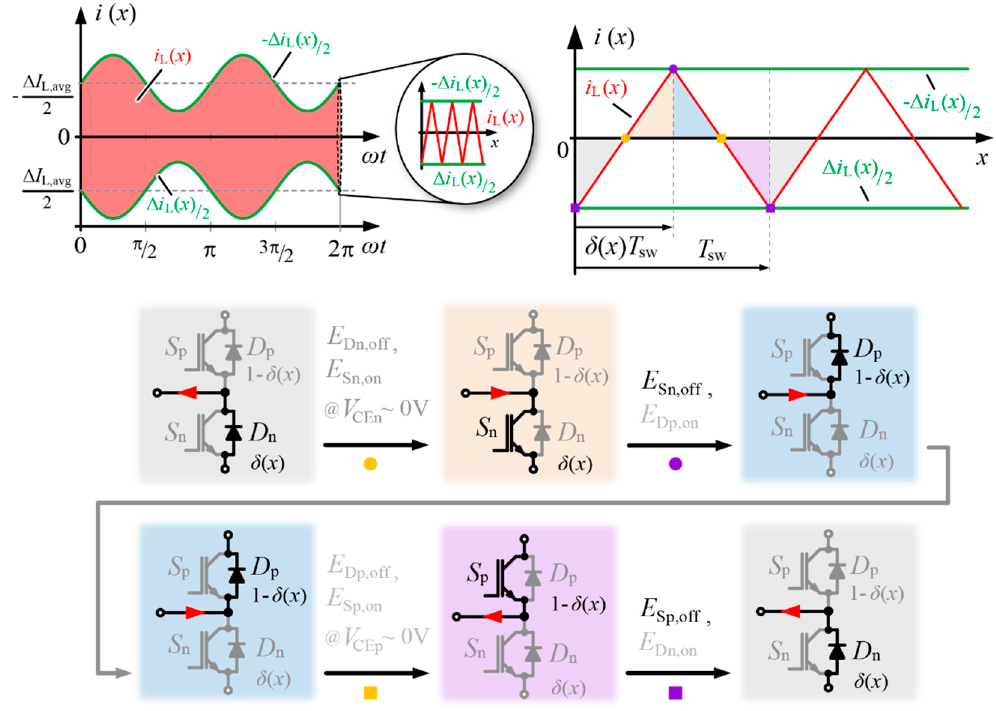
Figure 11. Derivation of switching losses of semiconductors under no-load condition.